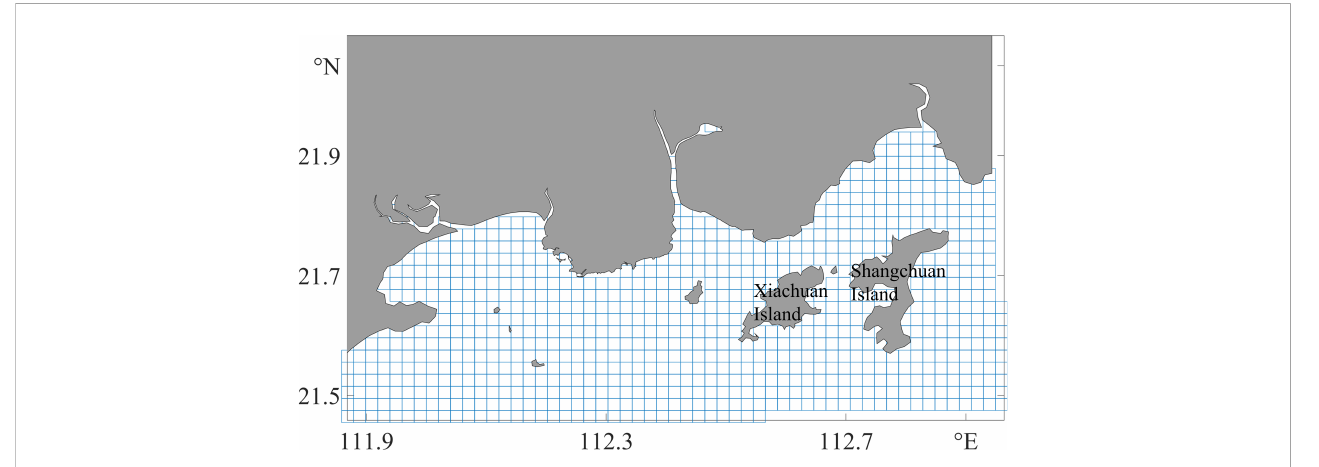
FIGURE 2 Vertices of the Lagrangian fl ow network (LFN) in the study